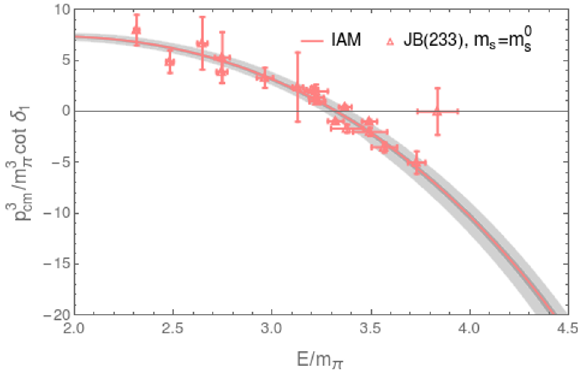
Figure 19 . Result of Fit IV in comparison with the JB data at m (cid:25) = 233 MeV [65].